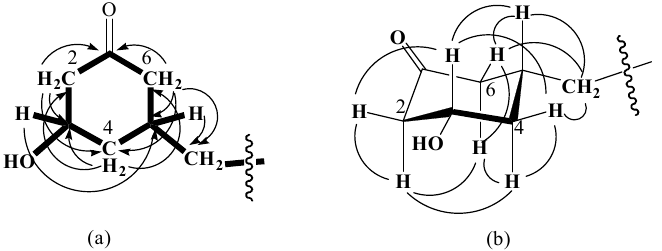
Figure 2. The key HMBC (a) and NOE (b) correlations of compound 2